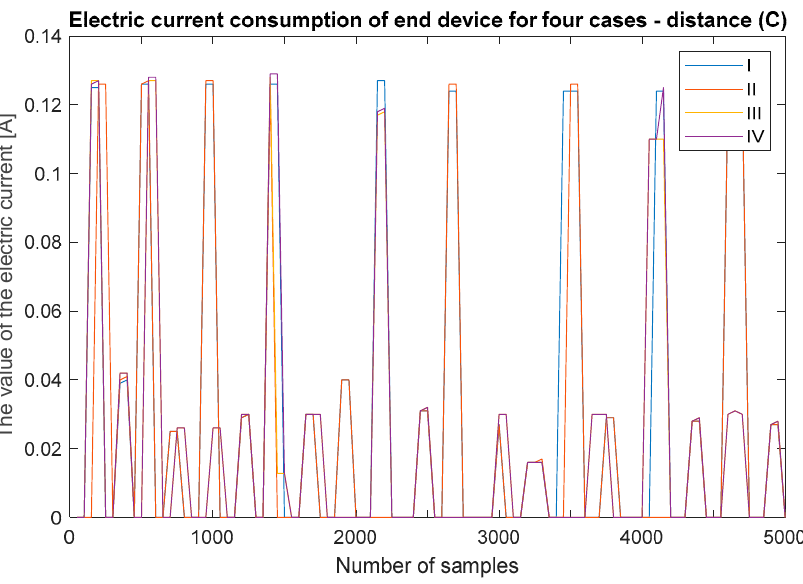
Figure 17. Graph of electric current consumption of the end device for four cases and devices— locations (C).